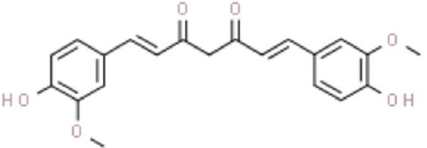
Figure 1. Structure of curcumin. It was drawn using ChemSpider, an online free chemical structure database.